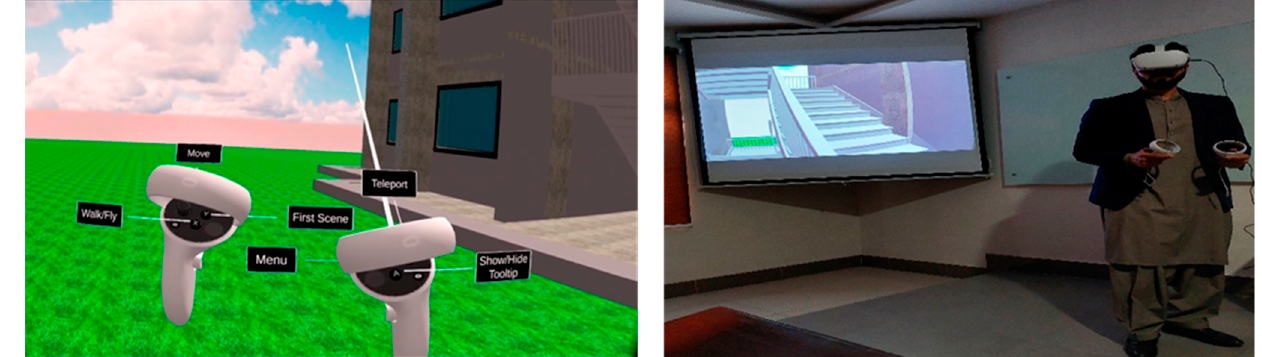
Figure 6. Controller setting for the participants in the Oculus Quest 2 virtual environment and par- ticipants performing the task in the immersive virtual environment.